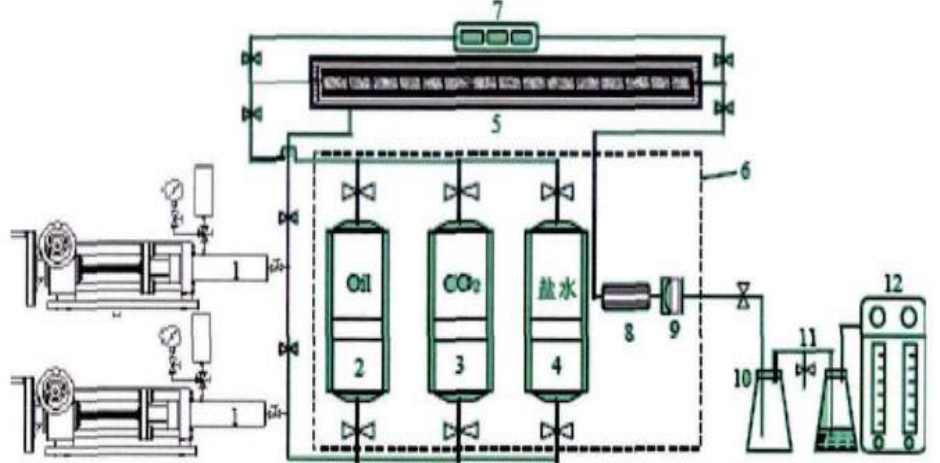
Figure 1—Device of displacement in the low-permeability core: 1.Displacement pump; 2.Oil vessel; 3.CO2 gas vessel; 4.Brine vessel; 5.Long core clamp; 6.Thermostat; 7.Pressure sensor; 8.Inspection window; 9.Pressure relief valve; 10.Separation bottle; 11.Sample tap; 12.Gasometer.